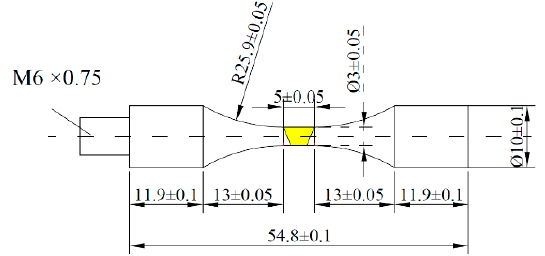
Figure 3. Very high cycle fatigue test specimen of EBW joints of TC17 titanium alloy (unites: mm).